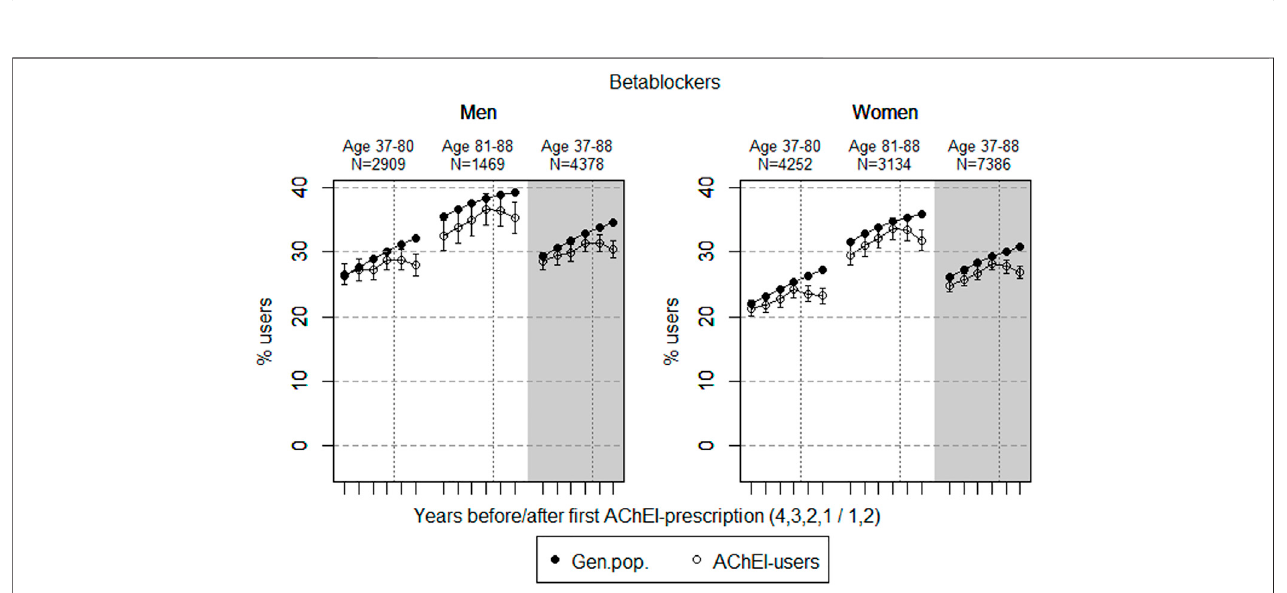
FIGURE 4 | Open circles: Proportion of men and women, respectively,of the study population who fi lled at least one prescription of betablockers (ATC C07) in the 4 yearsbeforeAChEIinitiationandthe2 yearsafterwith95%con fi denceintervals.Bullets:Thecorrespondingageadjustedproportioninthegeneralpopulation.Dashed vertical lines indicate AChEI initiation. The size of each age group in the study population is given on top.